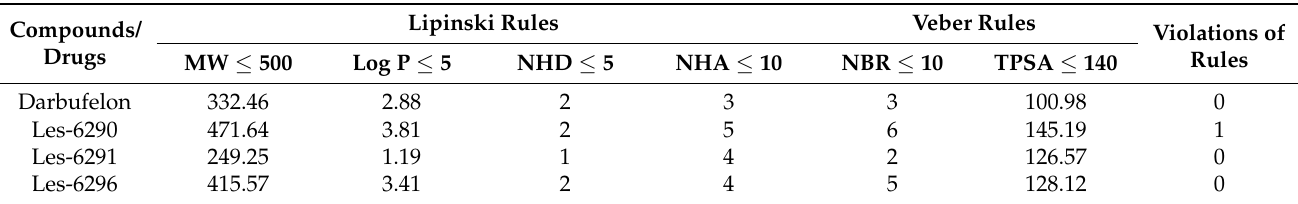
Table 1. Drug-likeness parameters of the darbufelon and derivatives Les-6290, Les-6291, and Les-6296 according to Lipinski and Veber rules.